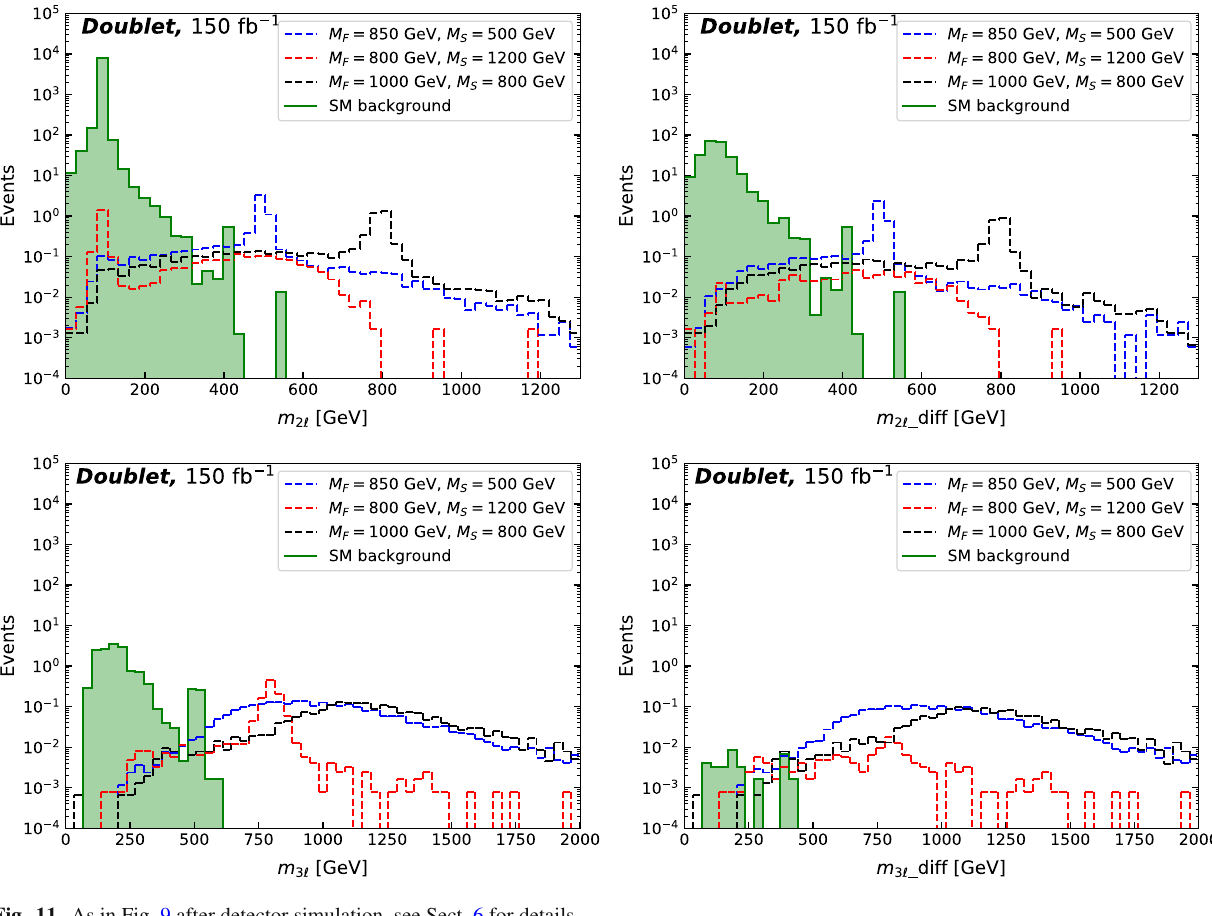
Fig. 11 As in Fig. 9 after detector simulation, see Sect. 6 for details